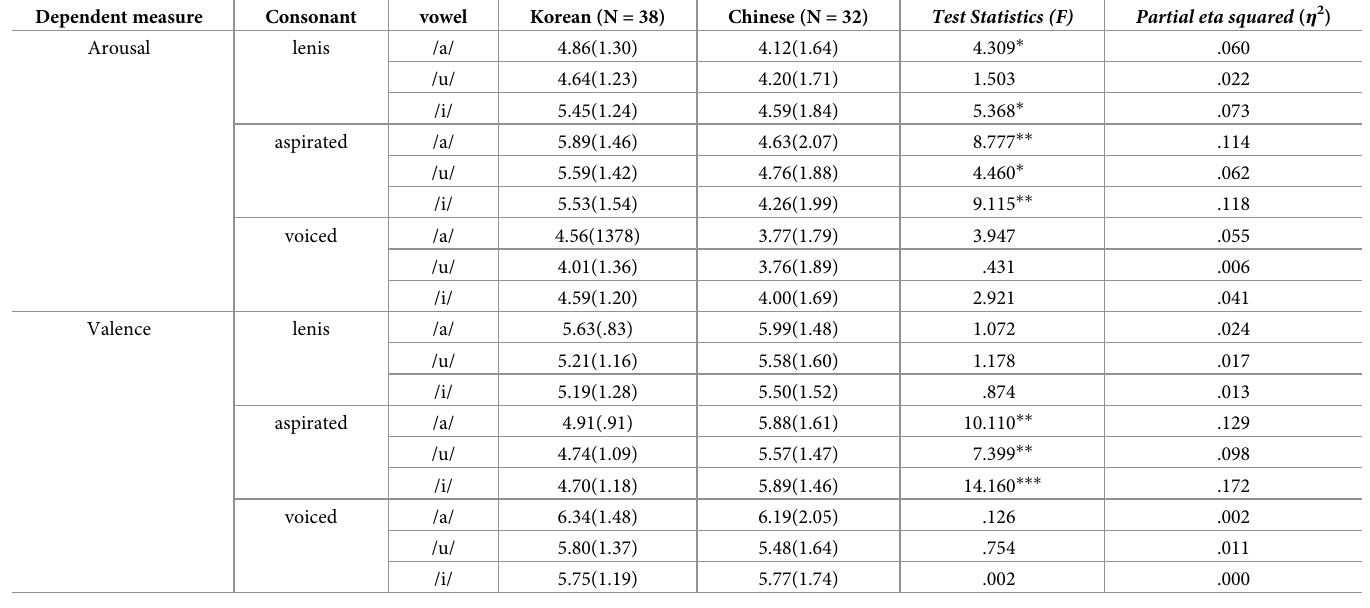
Table 3. Mean (SD) of arousal and valence of consonant and vowel between